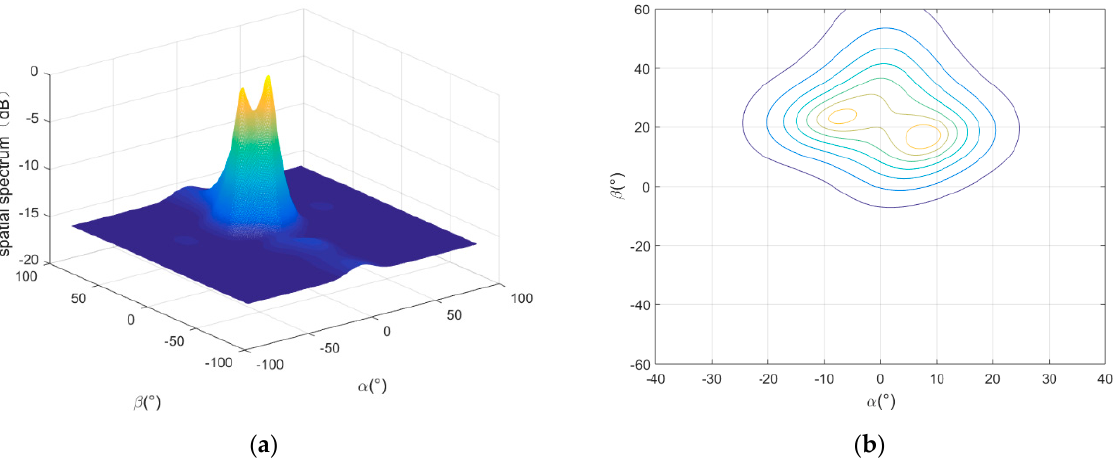
Figure 6. 2D MUSIC estimation results without self-calibration. ( a ) Spatial spectrum; ( b ) Contour map.